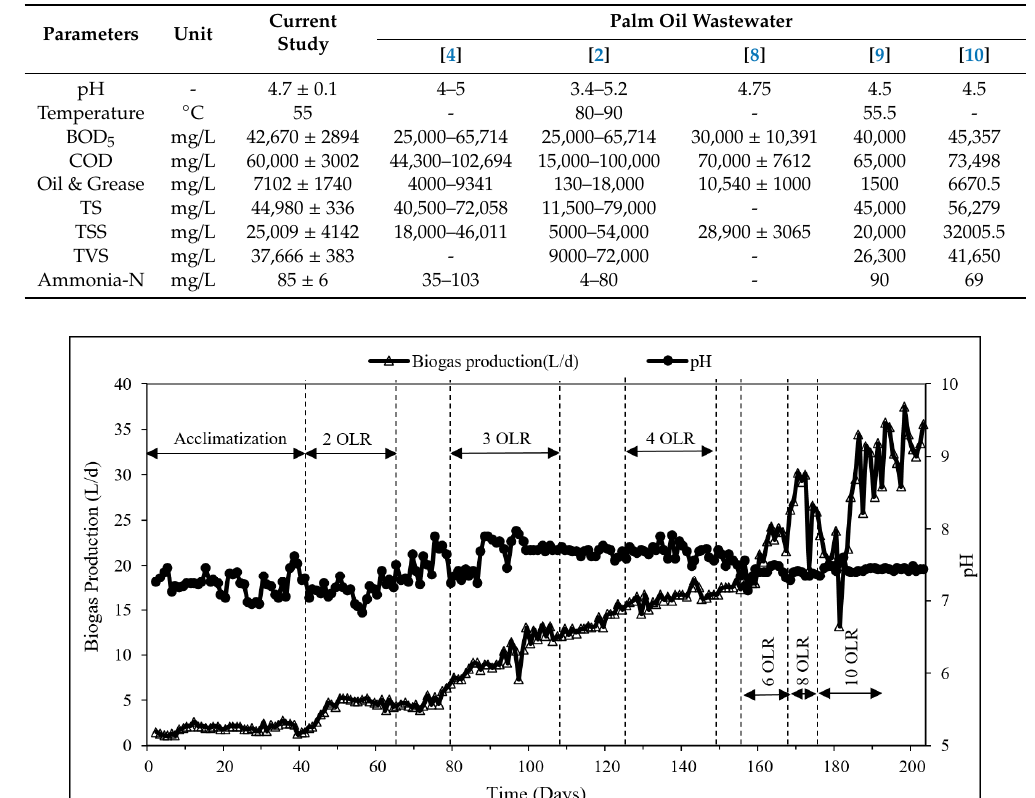
Figure 2. Biogas production during the operational period.